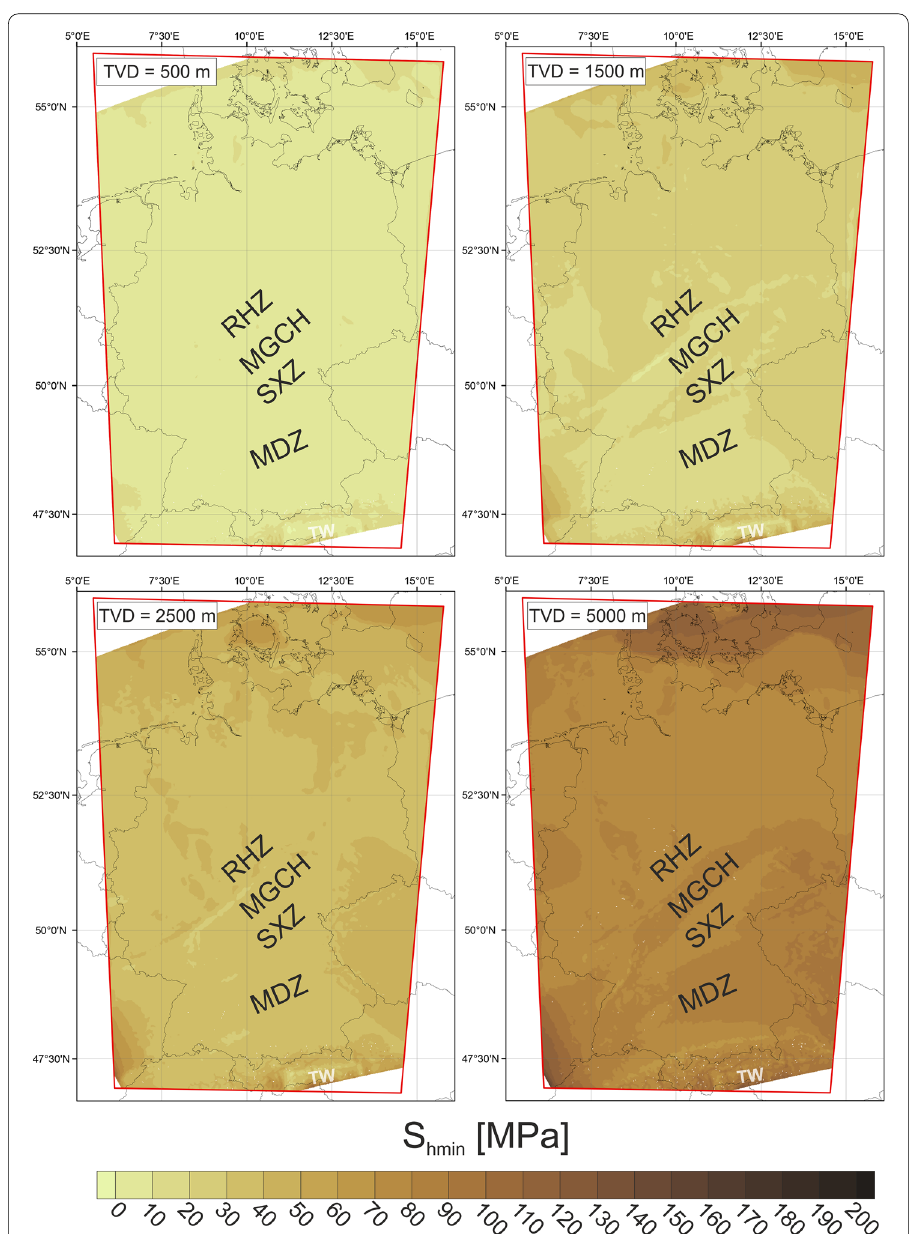
Fig. 7 Depth sections showing the lateral distribution of the S hmin magnitudes predicted by the model at four depth sections. TVD—true vertical depth. Black titles (details in Fig. 1d): MDZ—Moldanubian Zone, MGCH—Mid German Crystalline High, RHZ—Rhenoherzynian Zone, SXZ—Saxothuringian Zone. White title (details in Fig. 1c): TW—Tauern